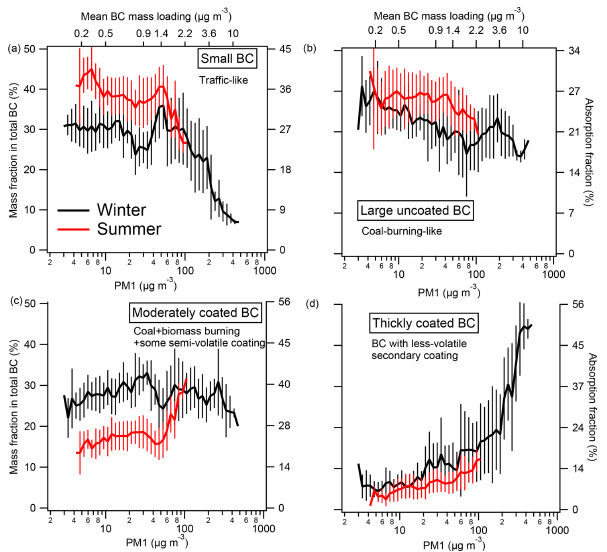
Figure 12. The mass (left y axis) contributions of different BC types at different pollution levels during winter and summer. The mean contribution of the absorption corresponding to the mass fraction for each BC type is shown on the right y axis. The mass fraction of each BC type is the average ± standard deviation at each PM 1 bin. The top axis shows the averaged rBC mass loading at each PM 1 bin, and the right axis indicates the average absorption fraction cor- responding with each rBC mass fraction.